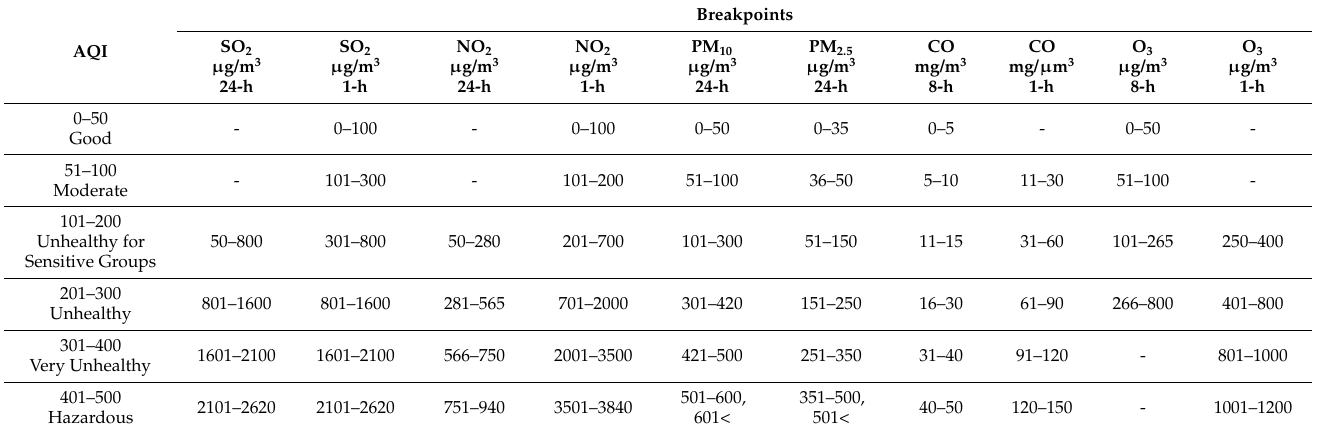
Table 1. AQI ranges and pollutant concentration limits